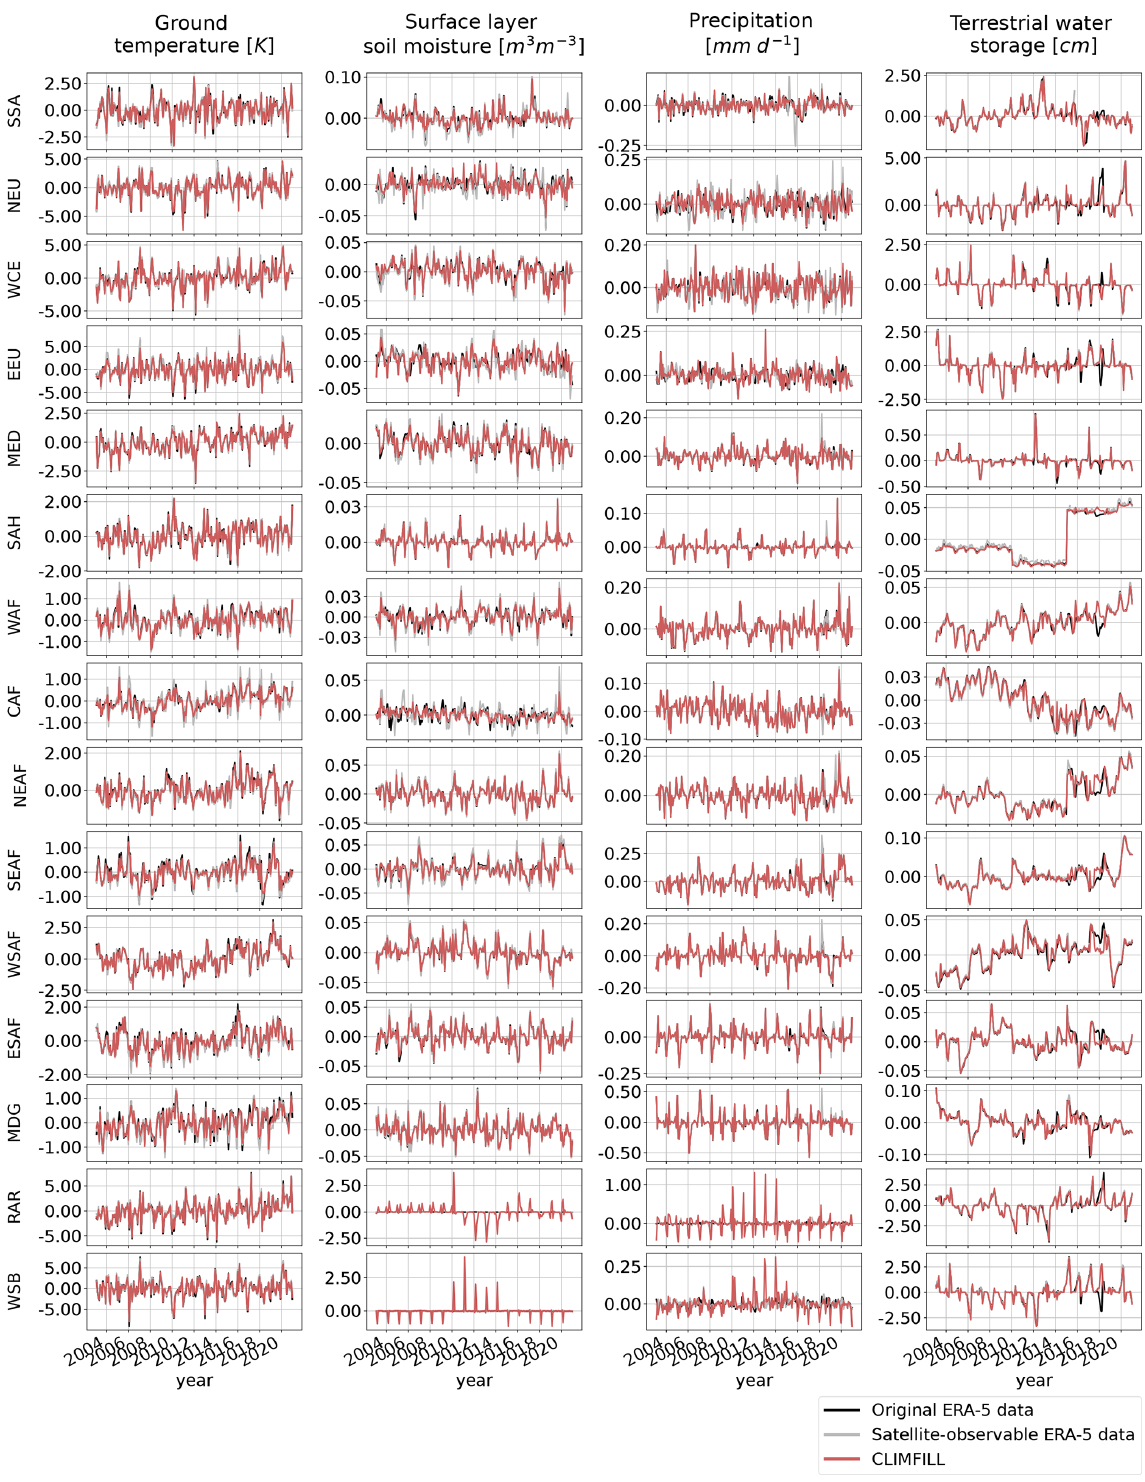
Figure A6. Figure A5